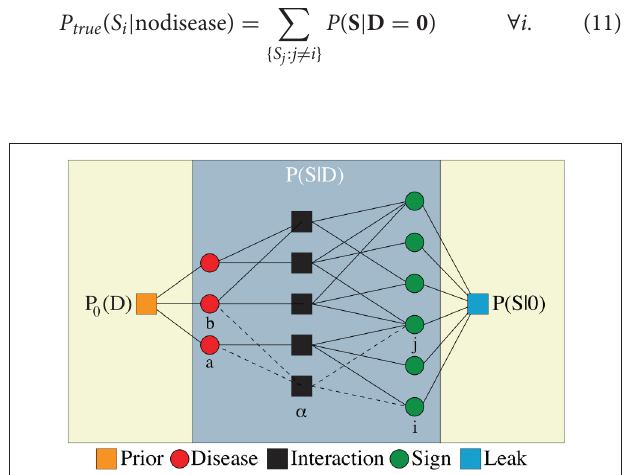
FIGURE 1 | The interaction graph of disease variables (left circles) and sign variables (right circles) related by M a two-disease interaction factors (middle squares) in addition to interactions induced by the leak probability (right square) and the prior probability of diseases (left square). An interaction factor α and l α